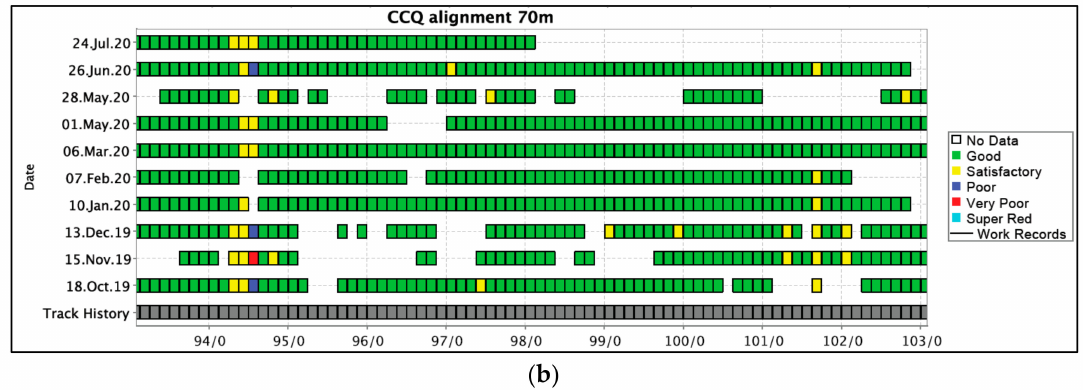
Figure 2. Track geometry results: ( a ) Peak value; ( b ) Average